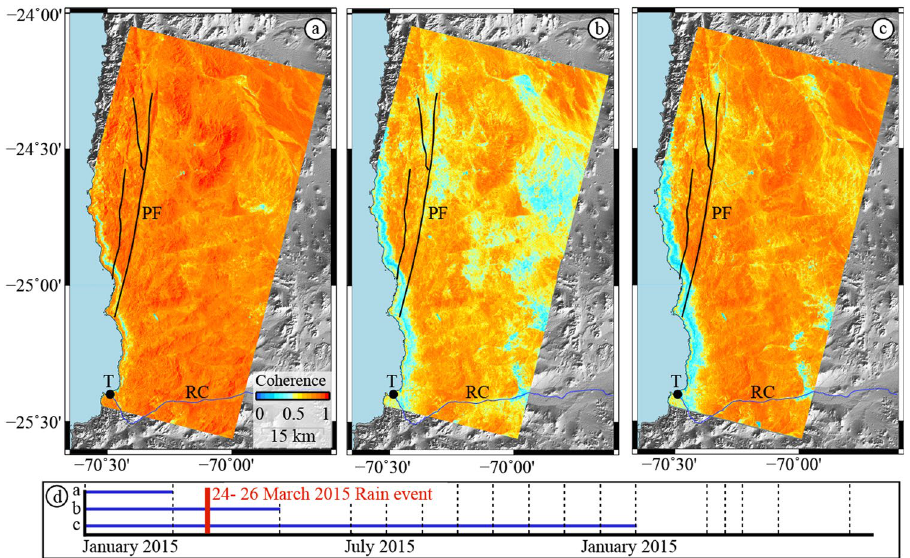
Figure 2. Coherence of three interferograms from Track 54, Swath 1. Interferograms between January 1, 2015, and 3 different dates: ( a ) before the event - March 2, 2015, ( b ) soon after the event - May 13, 2015, ( c ) significantly after the event - January 18, 2016. Note that the year-long interferogram has higher coherence than the 4.5 month interferogram, except for in regions with significant relief, such as the coastal escarpment north of Taltal. ( d ) Timespan of interferograms shown in a – c (blue bars), relative to timing of 24–26 March rain event (red bar). T: City of Taltal, RC: Rio Chaco, PF: Paposa Fault. All available dates shown in Supplementary Figure 1. Figures generated using Generic Mapping Tools 50 , v.